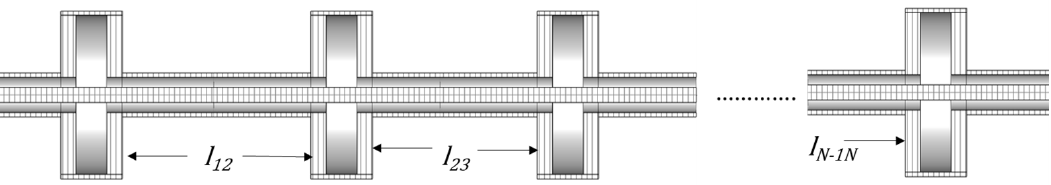
Figure 3. Cross section of the coupling of N coaxial resonators, l ij being the intracavity coupling lines.